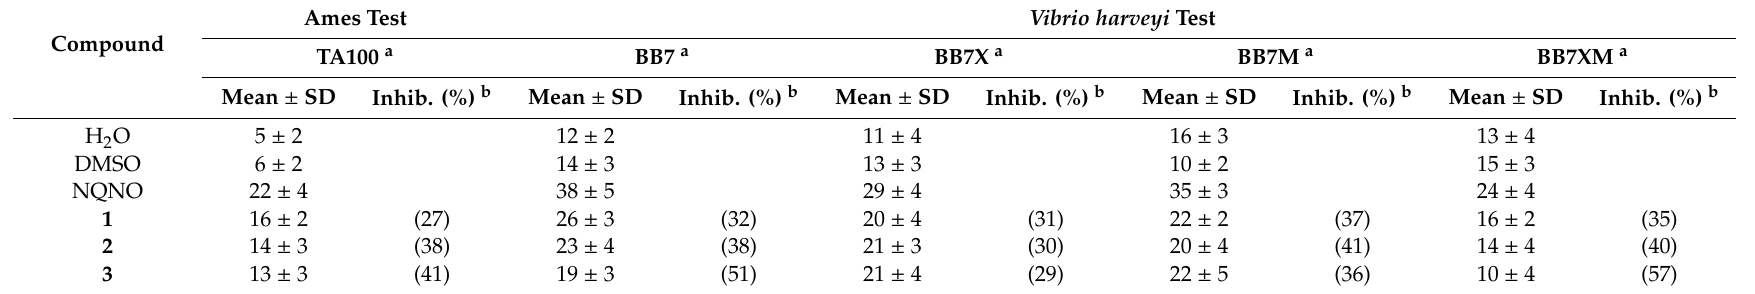
Table 3. Antimutagenic activity of compounds 1 – 3 in the Ames and the Vibrio harveyi